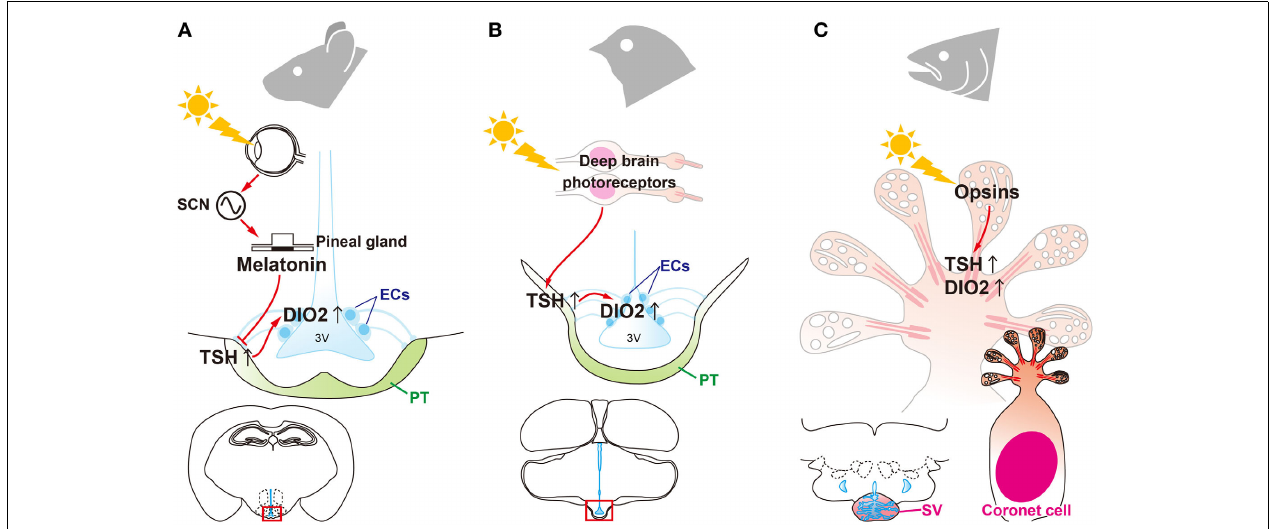
FIGURE 3 | Universality and diversity of signal transduction pathways that regulate seasonal reproduction in vertebrates. (A) Eyes are the only photoreceptor organ in mammals. Light information is transmitted through the suprachiasmatic nucleus (SCN) to the pineal gland. Photoperiodic information is encoded by the pattern of melatonin secretion from the pineal gland. Melatonin regulates the “springtime